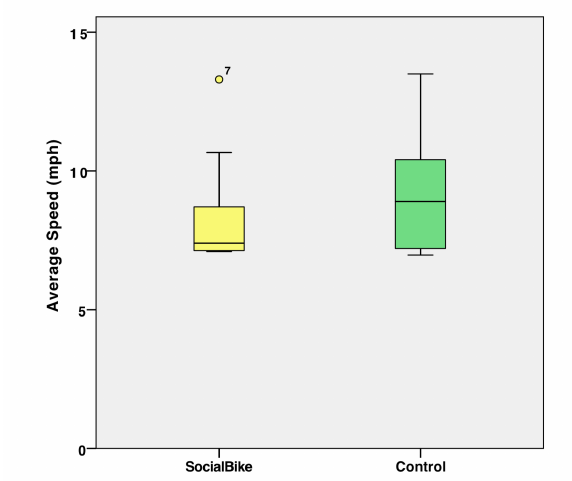
Figure. 17. The result of Average Speed